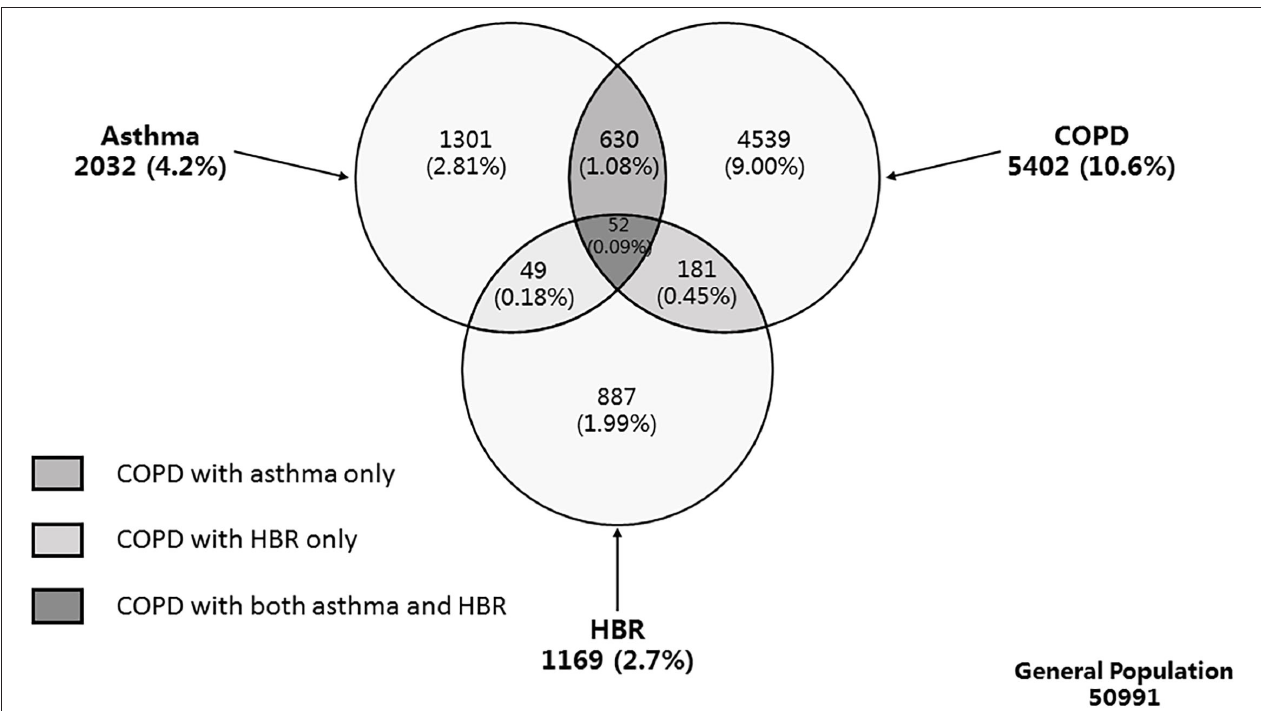
FIGURE 1 | Venn diagram of weighted population prevalence of asthma, COPD, and HBR. Definition of abbreviations: COPD, chronic obstructive pulmonary disease; HBR, high bronchodilator responsiveness; LLN, lower limit of normal. Asthma was defined as physician-diagnosed asthma and/or wheeze in the preceding 12 months. COPD was defined as post-bronchodilator FEV 1 /FVC of less than LLN. HBR was defined as an increase in FEV 1 of more than 15% and more than 400ml from baseline, 20min after bronchodilator with 400 µ g salbutamol. COPD with concomitant features of asthma was defined as COPD with asthma or with HBR.